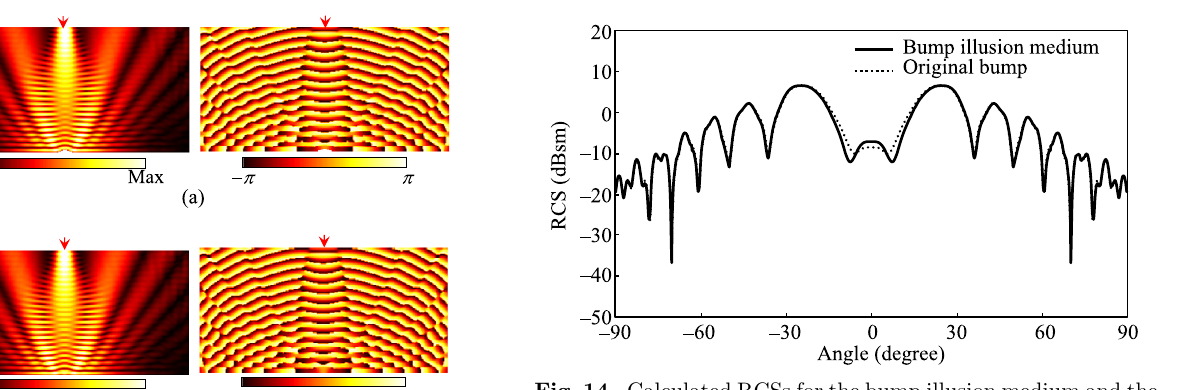
Fig. 14. Calculated RCSs for the bump illusion medium and the original